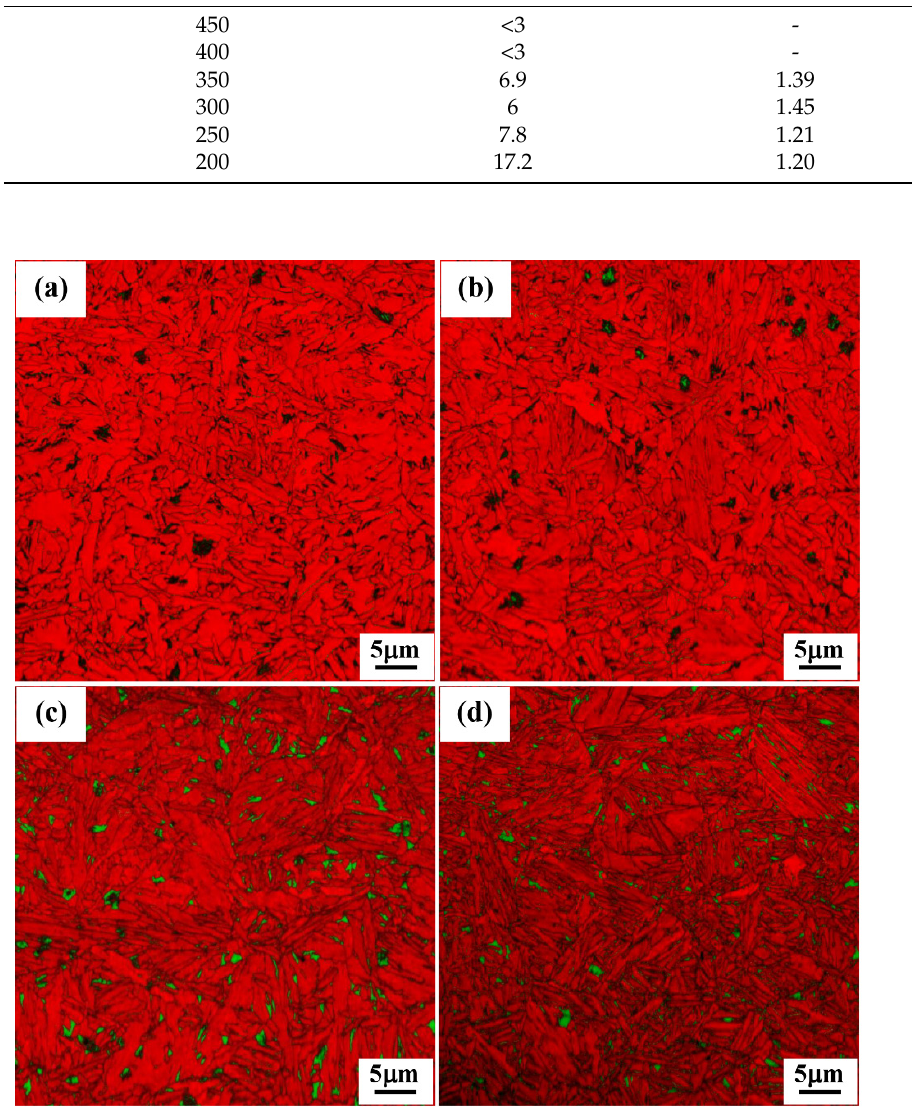
Figure 12. EBSD images of samples held at: ( a ) 450 °C, ( b ) 400 °C, ( c ) 350 °C and ( d ) 300 °C for 1 h isothermal holding. The RA is shown in green and the bainite is red-colored.